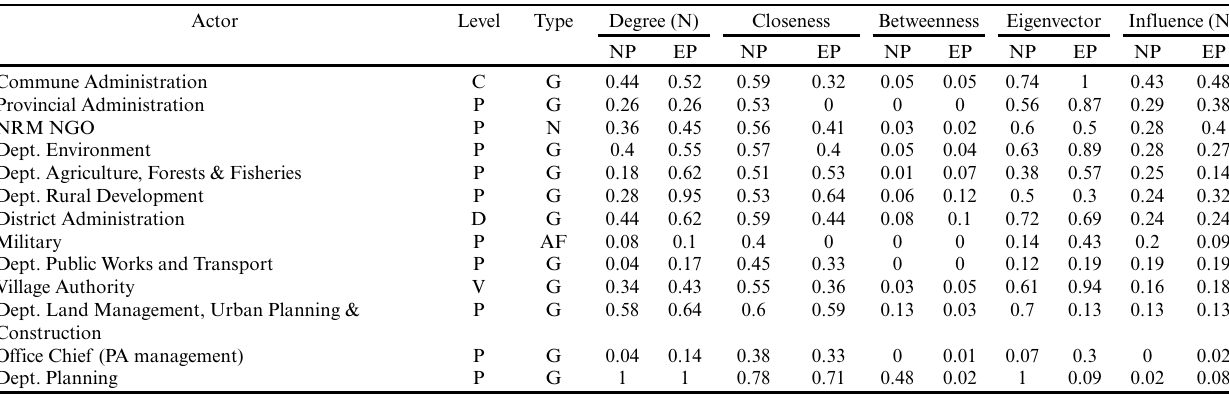
Table 3. Key actors and centrality scores for the information sharing network in NP and EP. Degree and Influence are normalized values (N). Actors are categorized by the highest level they operate (C=Commune, P=Province, D=District, V=Village) and by type (G=Government, N=NGO, AF=Armed Forces).